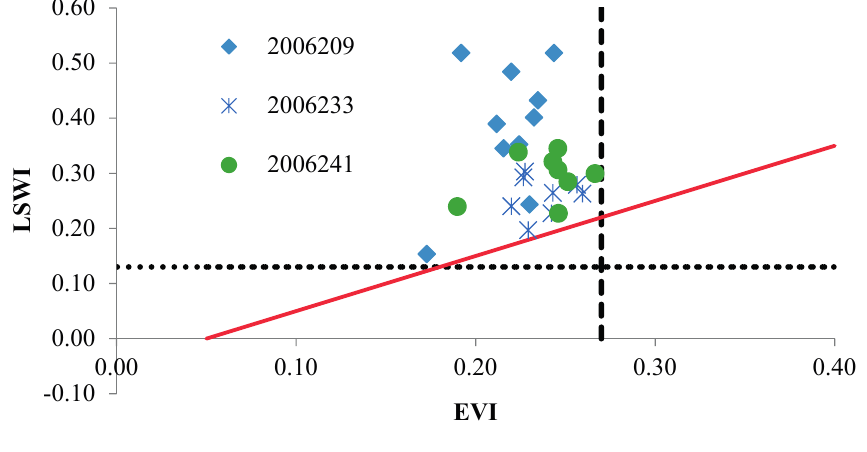
Figure 7. Characteristics of paddy rice fields reflected by EVI and LSWI in the transplanting period according to ground observation sites during 2006–2007 Kharif season. The red line is the threshold for potential rice in the transplantation season based on our analysis.